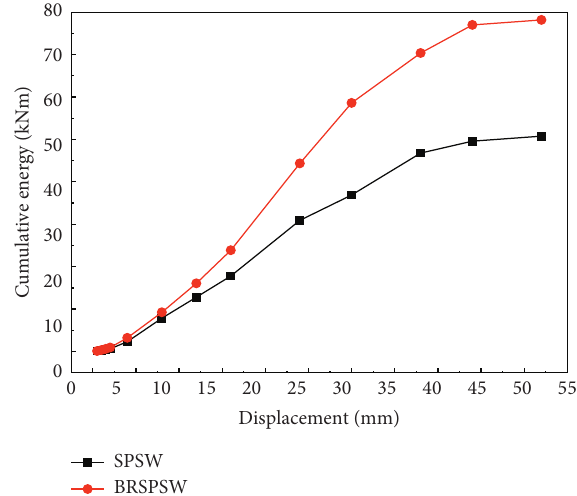
Figure 19: Cumulative energy dissipation at each loading step of both